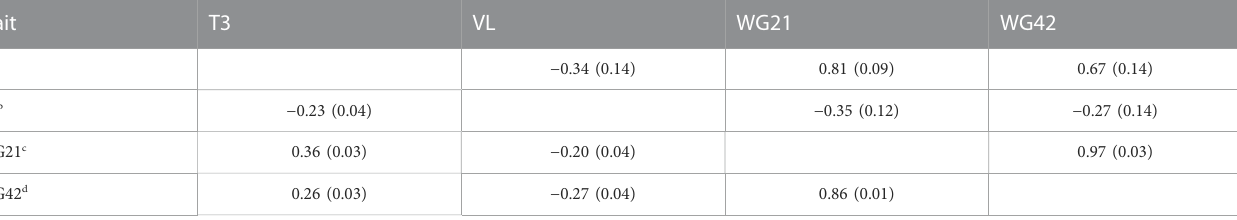
TABLE 2 Estimates of phenotypic (below diagonal) and genetic (above diagonal) correlations (SE) between thyroid hormone level, VL, WG21, and WG42 in piglets. Trait